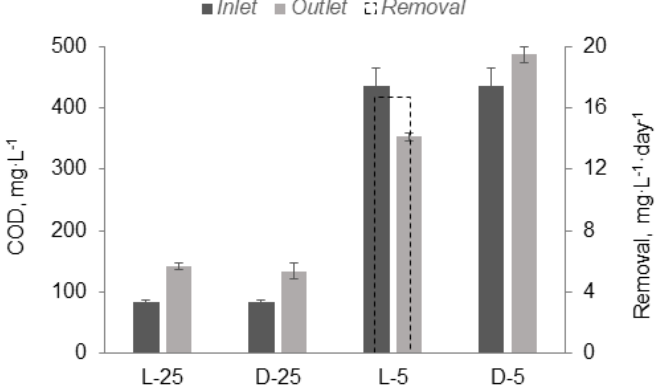
Figure 3. Inlet and outlet concentration and removal/production of COD in L-25, D-25, L-5, and D-5.